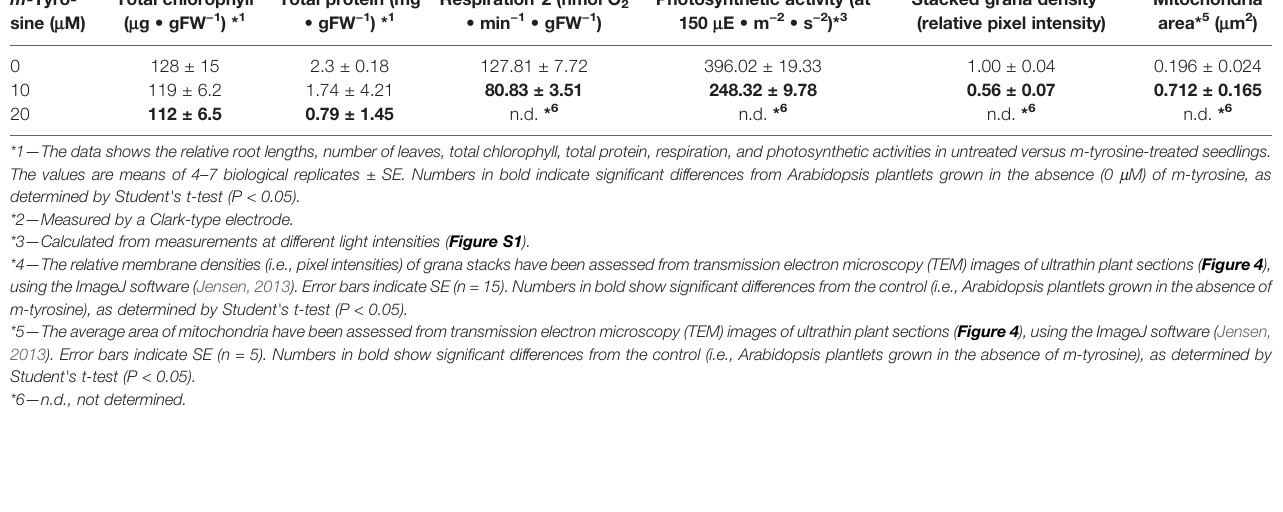
TABLE 2 | Effects of m -tyrosine on protein levels and organellar activities of 5-day-old Arabidopsis thaliana (Col-0) seedlings. m -Tyro- sine ( m